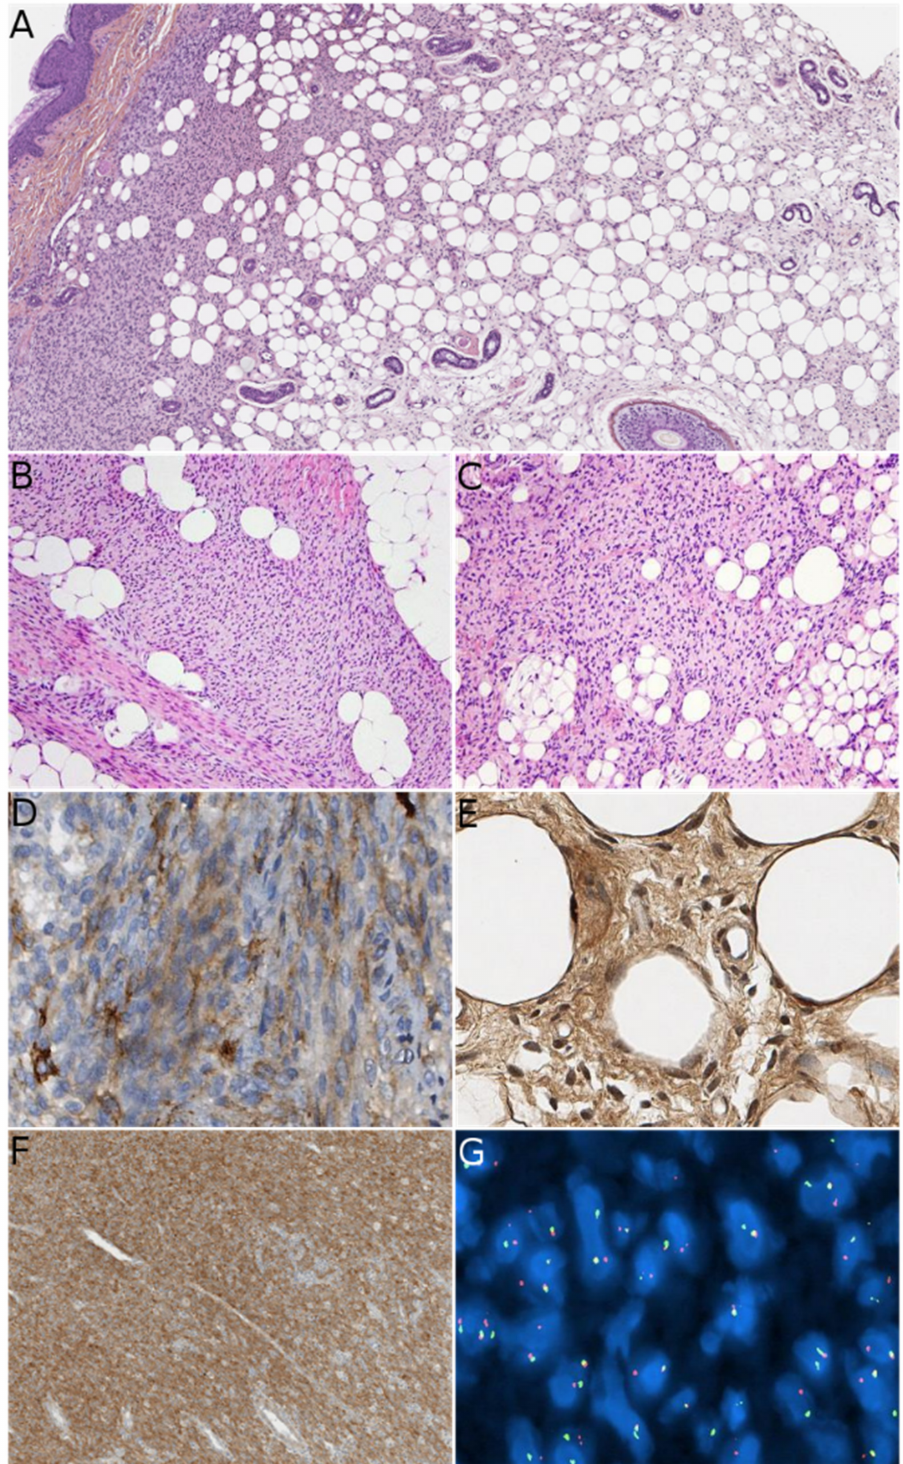
Figure 5. Lipofibromatosis-like neural tumor (LPF-NT). ( A ) Low-power view showing extension of the tumor in both the dermis and subcutis (HE × 50). ( B ) Spindle cells in fascicles admixed with adipose tissue (HE × 100). ( C ) Some areas can lack the typical fascicular growth (HE × 100). ( D ) Heterogeneous positivity for CD34 ( × 400). ( E ) Positivity for S100 ( × 400). ( F ) Diffuse positivity for NTRK1 ( × 200). ( G ) FISH showing fusion transcripts between NTRK 1 and LMNA . (Courtesy